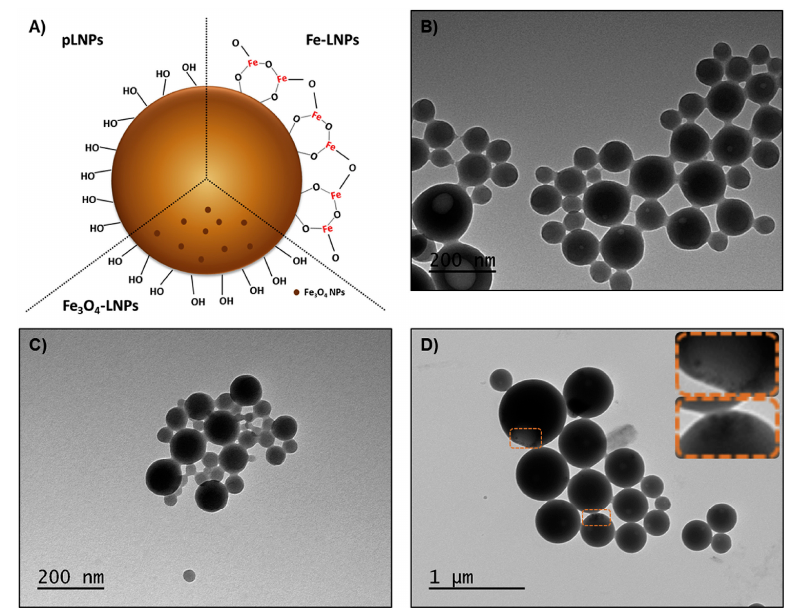
Figure 6. Schematic representation of the three types of lignin nanoparticles (LNPs) ( A ), and TEM images of ( B ) pLNPs, ( C ) Fe-LNPs and ( D ) Fe 3 O 4 -LNPs and magnification of the Fe 3 O 4 NPs inside the LNPs. (Reprinted with permission from [52]).